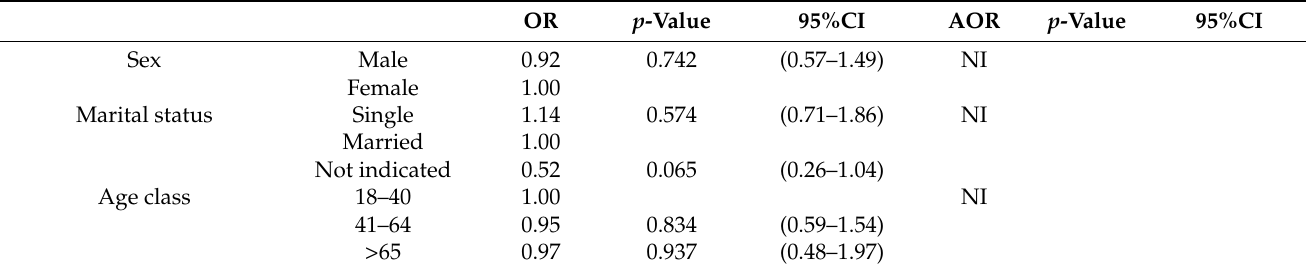
Table 5. Association of some characteristics with a patient delay (PD) > 30